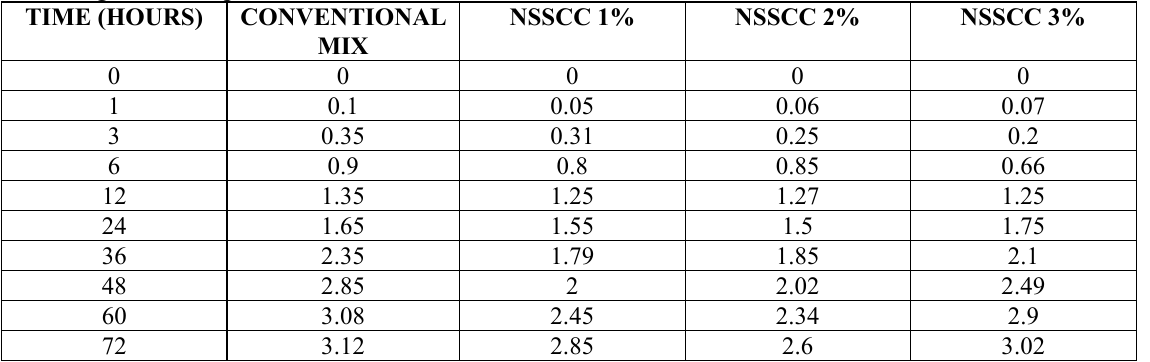
Percentage of Desorption values of Nano Silica.